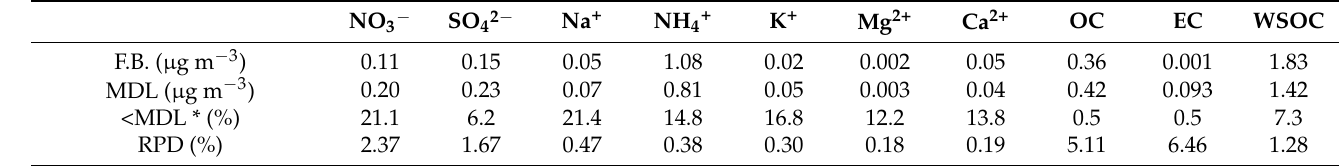
Table 1. Summarized QA/QC results for PM 2.5